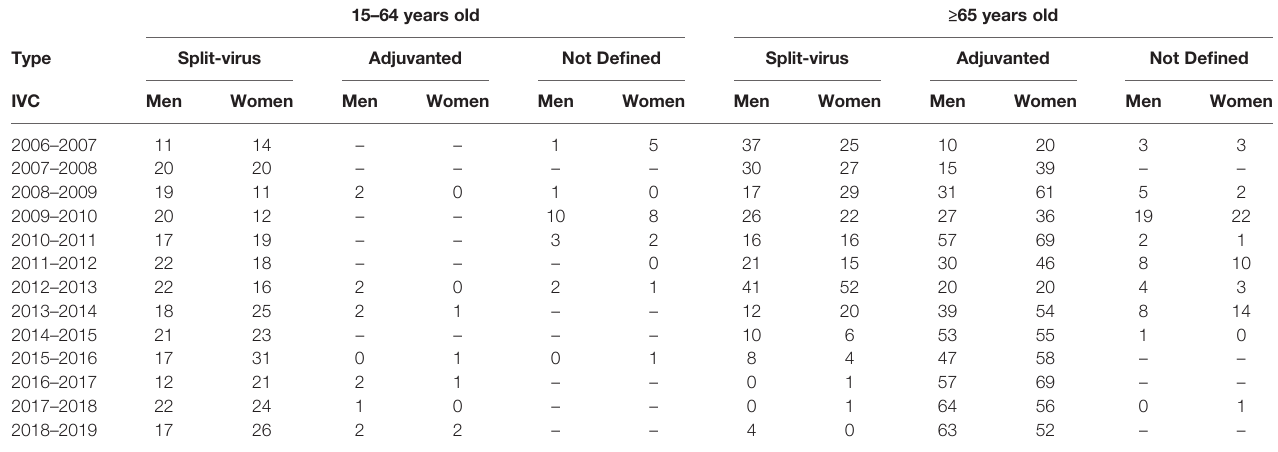
TABLE 1 | Details of the different vaccines used during each IVC following the WHO recommendations divided by gender and